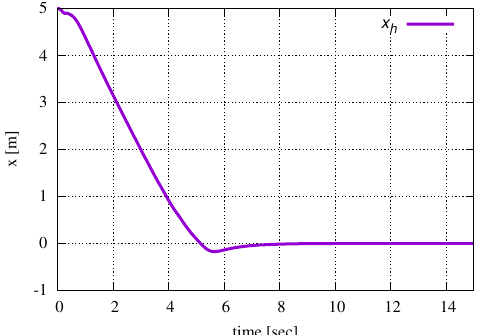
Figure 17. Case 2: Time variation of the x coordinate of the head position.